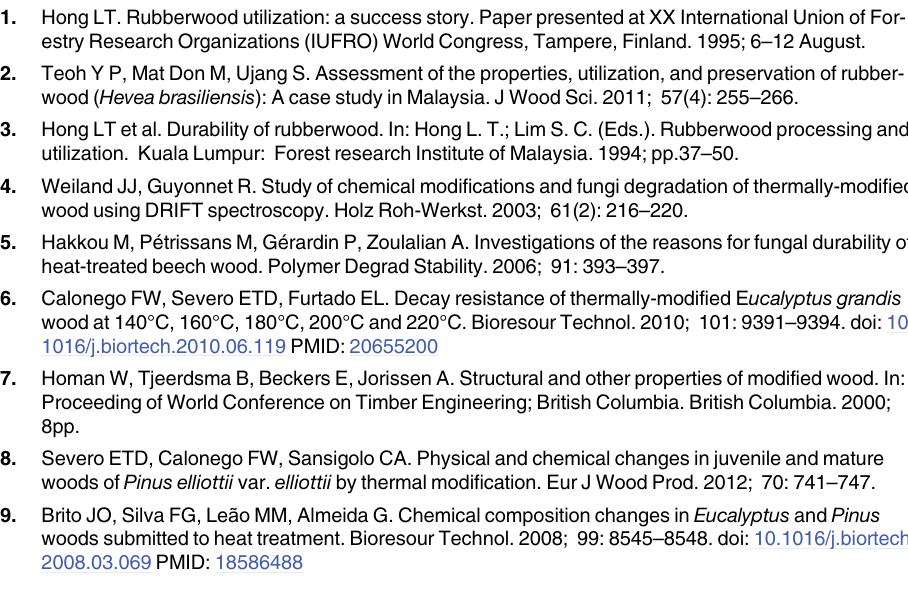
S1 Table. Minimal data set of chemical properties of juvenile and mature woods from ther- mally-modified rubberwood. S2 Table. Minimal data set of decay of juvenile and mature woods from thermally-modified rubberwood at fungus Pycnoporus sanguineus . S3 Table. Minimal data set of decay of juvenile and mature woods from thermally-modified rubberwood at fungus Gloeophylum trabeum